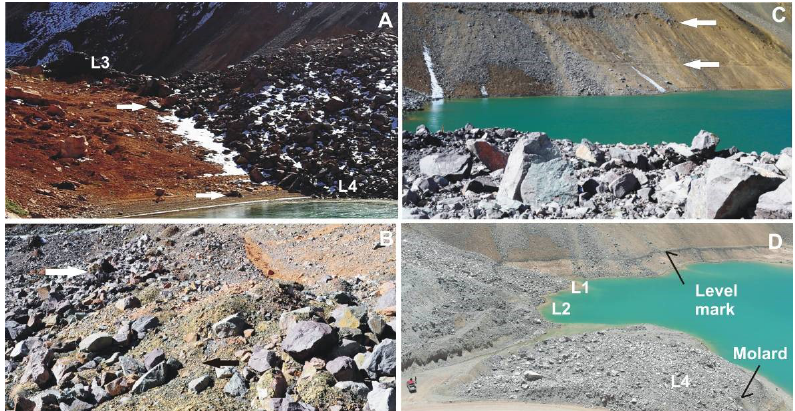
Figure 7. Details of Flow 1 deposit. ( A ) Distal-preserved front of Flow 1 showing two lobes (L3 and L4) with their frontal slopes and a few outrunners (white arrows). ( B ) A view of the texture of the deposit showing patches of matrix-rich debris (black arrow), while in other sectors it is almost absent (white arrow). ( C ) Outlook of the chaotic rocky deposit on top of L3. Largest boulder in the foreground is 1.5 m diameter. ( D ) Present day drained lake and altered dam showing part of the road and lobes (L1 and L2), also shown in Figure 2. Note the remaining molard and the preserved water level mark created after 16 years of stable lake level.